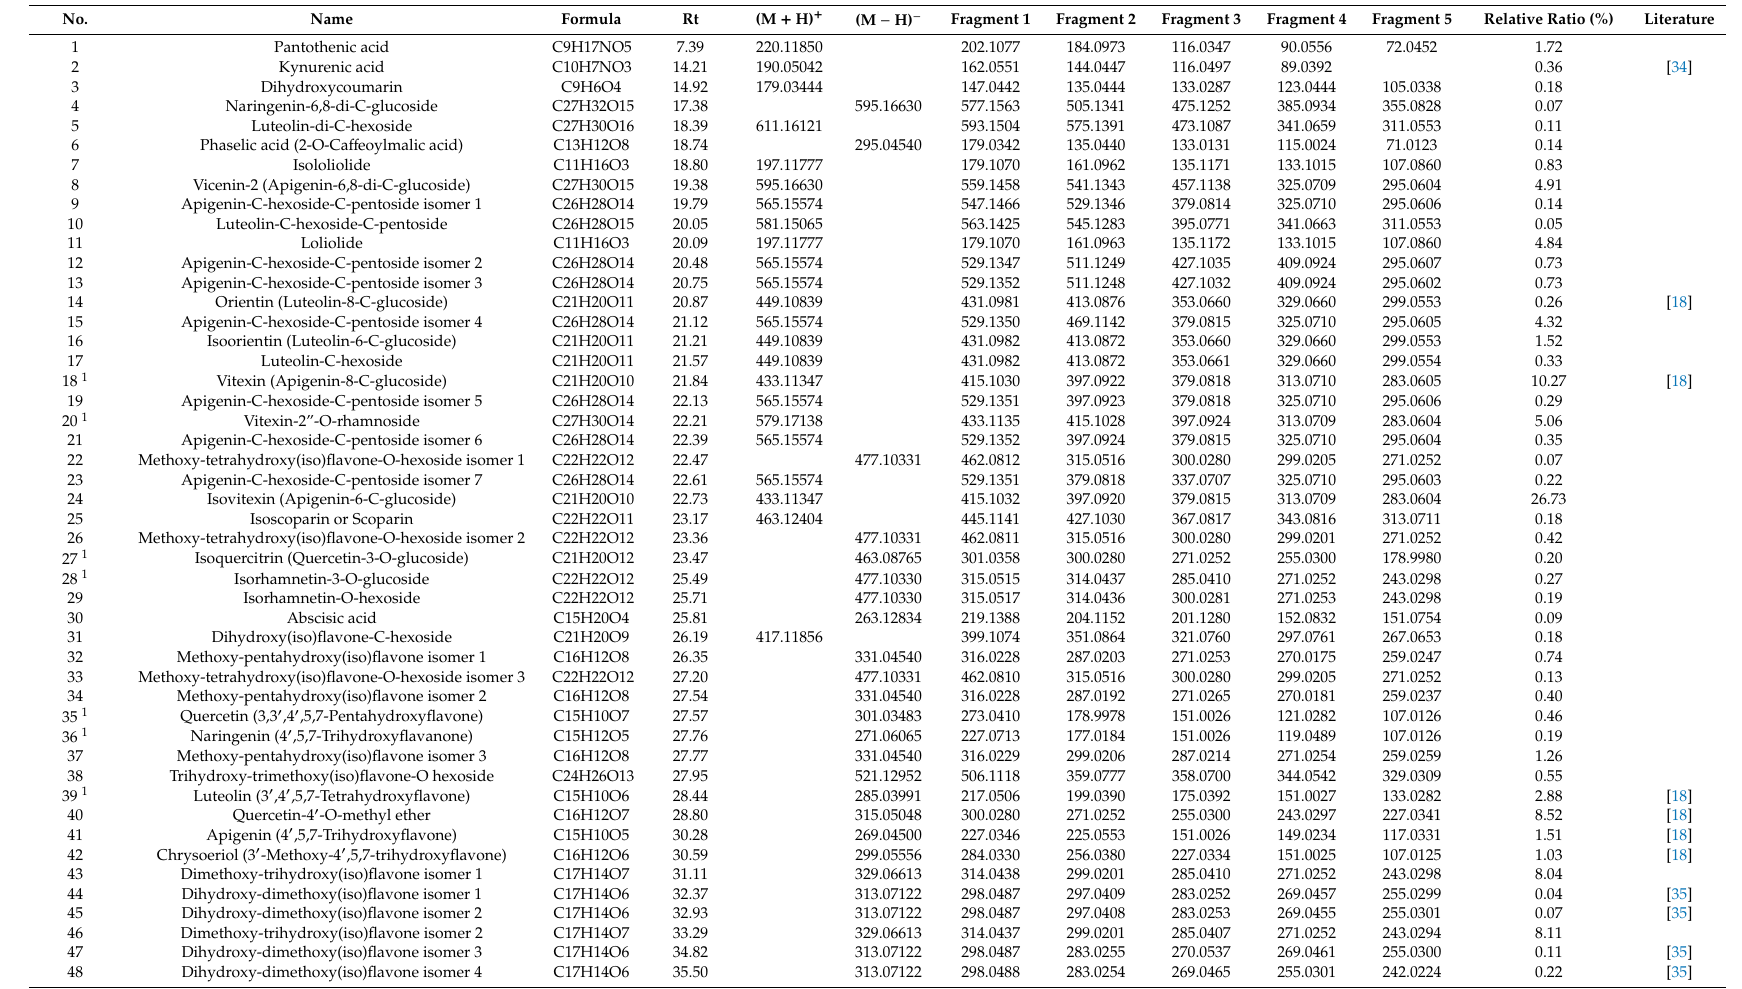
Table 3. Chemical profile of methanolic